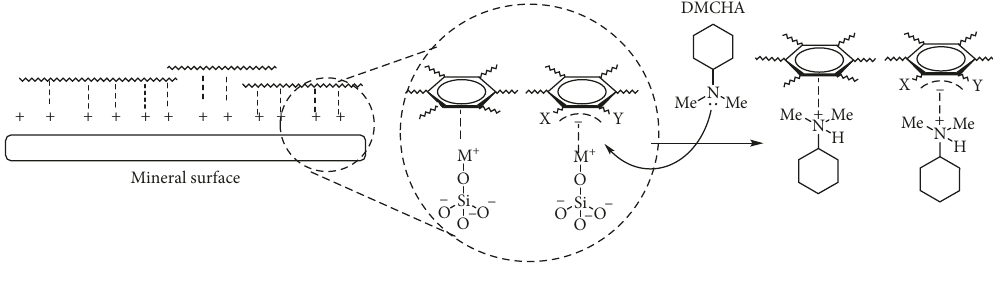
Scheme 1: Mechanism proposal for crude oil-DMCHA interaction based on preliminary studies and the results obtained.